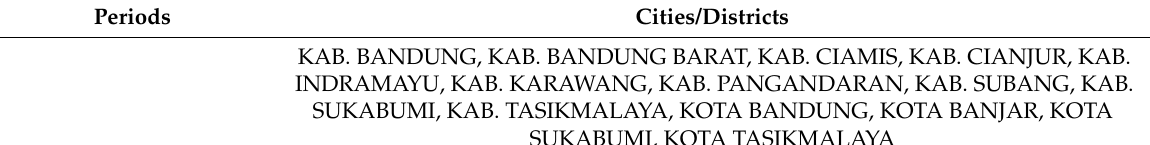
Table 1. Clusters of daily COVID-19 cases in cities and districts in West Java.